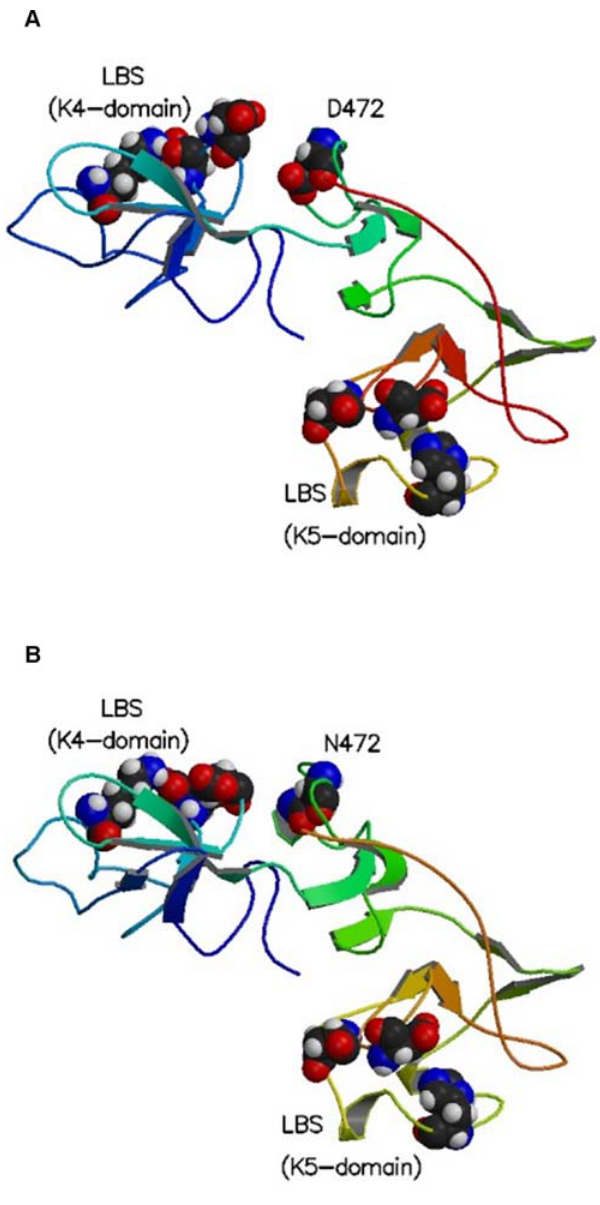
Figure 4. Ribbon diagrams of the combined kringle 4 (K4) and kringle 5 (K5) domains of human plasminogen. (A) Ribbon diagram showing Asp472 and the relationship to a major lysine binding site (LBS) on kringle 4. (B) Asp472 in the native K4K5 structure mutated to Asn.